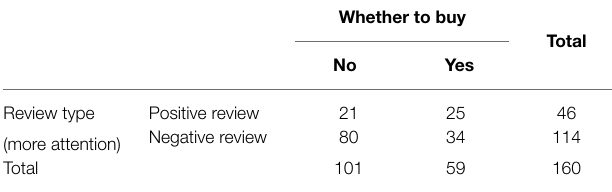
TABLE 4 | Frequency statistics of purchasing